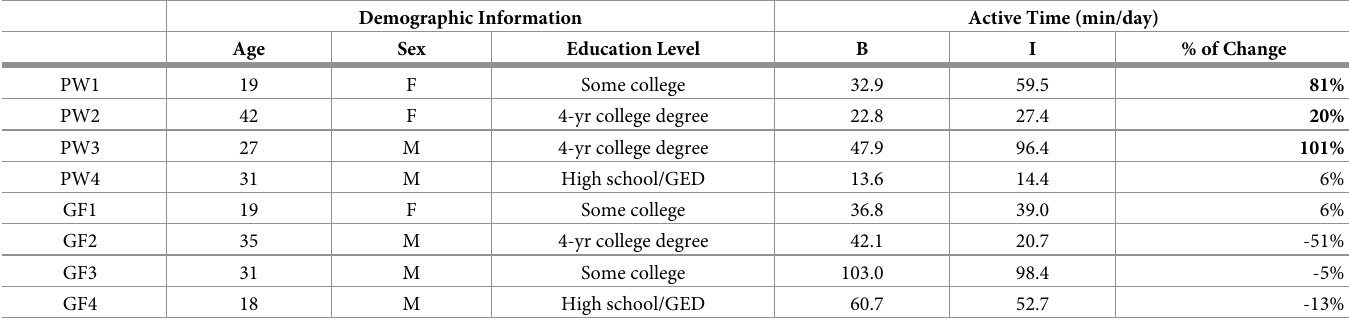
Table 2. Demographic information of the field study participants and active (walking) time. “B” = Baseline & “I” =